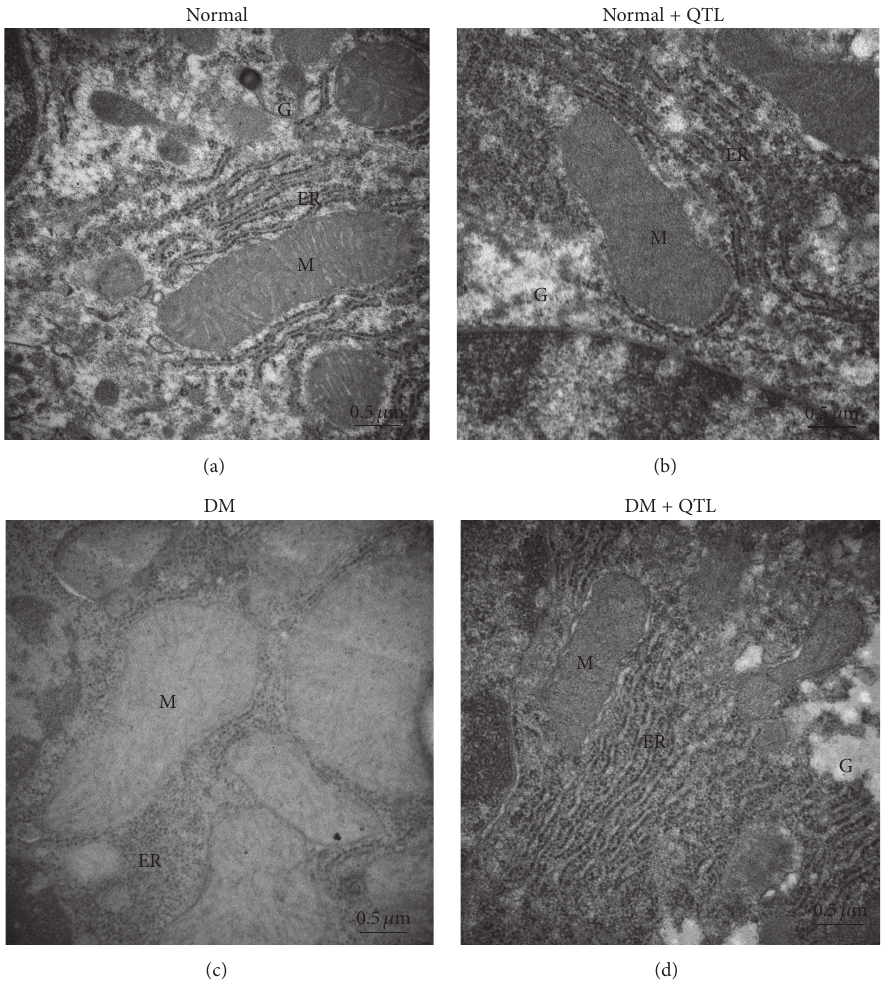
Figure 4: Transmission electron microscopy of hepatocytes of normal and diabetic mice. At the end of experimental period, the mice were sacrificed and the hepatic tissues were sectioned for the transmission electron microscopic studies. Transmission electron micrographs of (a) normal, (b) normal + QTL, (c) diabetic, and (d) diabetic + QTL treated mice’s hepatic tissue sections were showed at 10,000x magnification. Endoplasmic reticulum (ER), glycogen (G), and mitochondria (M).